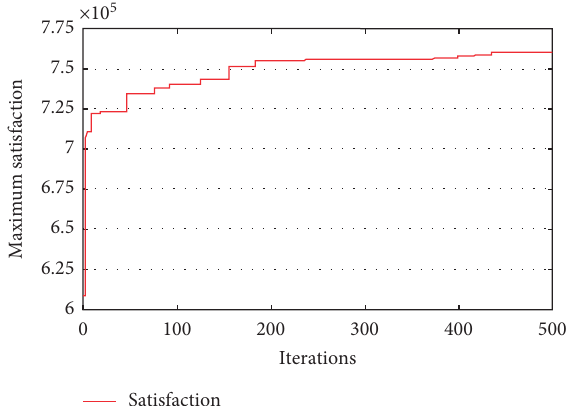
Figure 4: Algorithm iteration result graph with 15 min departure